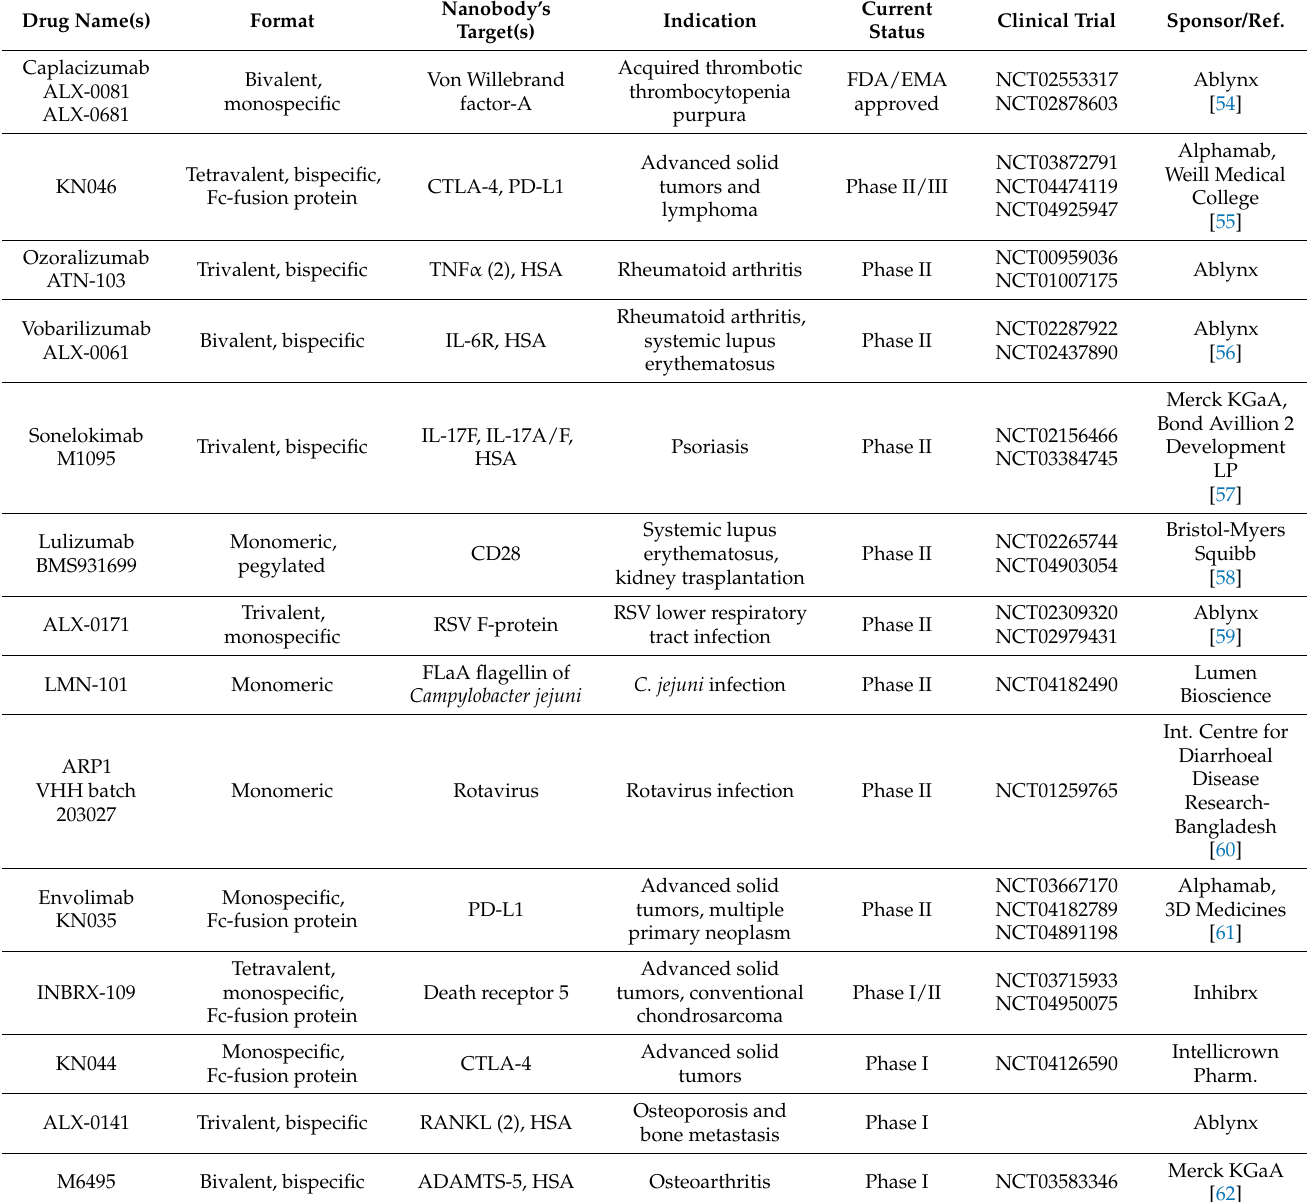
Table 1. Therapeutic nanobodies in clinical